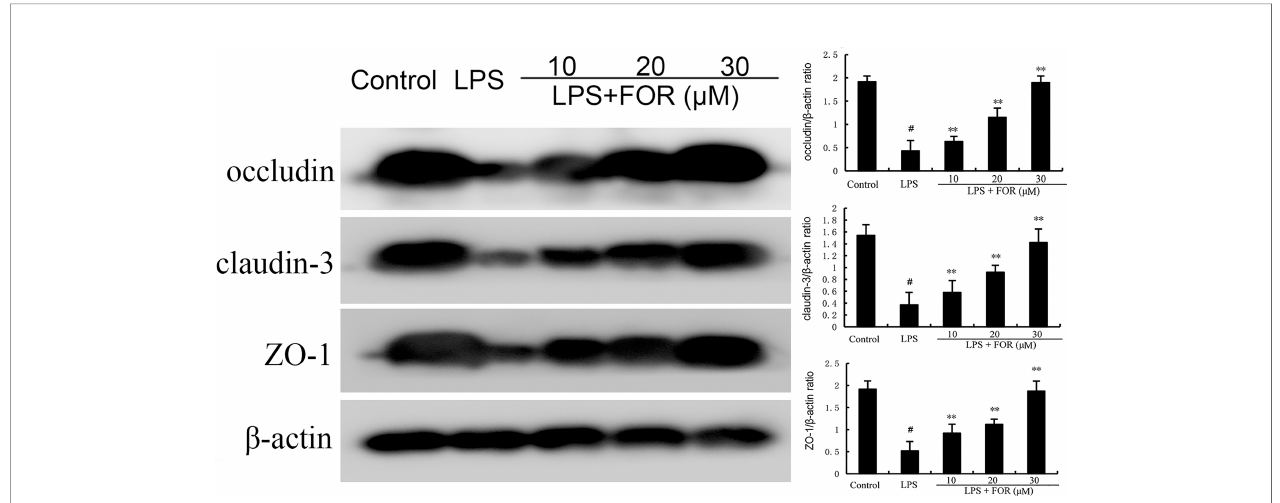
FIGURE 5 | FOR promotes the expression of tight junction-related proteins. The present results are displayed as the mean ± SEM of triple parallel measurements. # ( P < 0.01) is signi fi cantly different from control group; **( P < 0.01) is signi fi cantly different from LPS group.